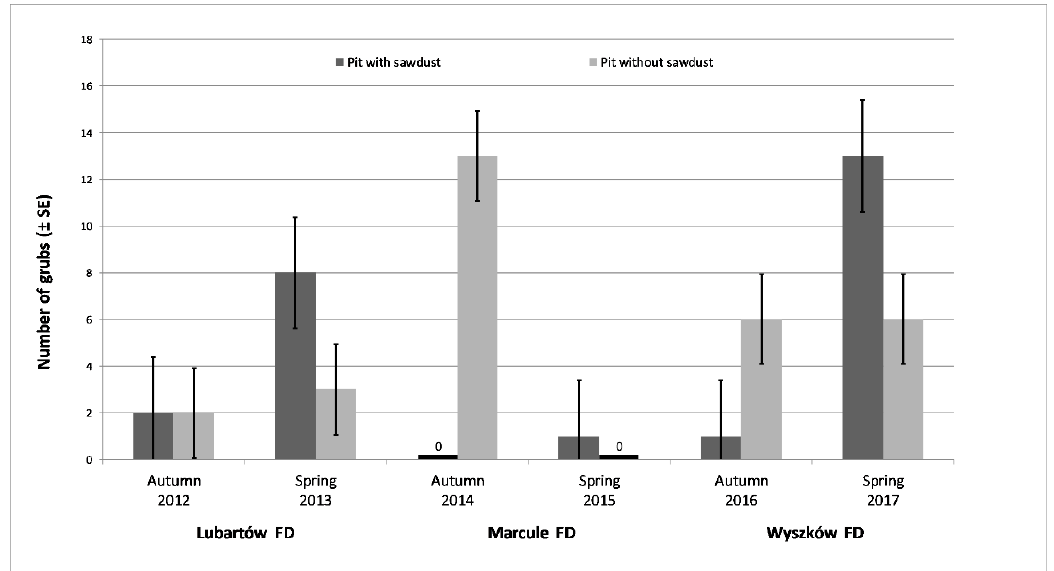
Figure 4. Comparison of the numbers of cockchafers found in pits of different treatments between evaluated periods at particular forest districts (FD).